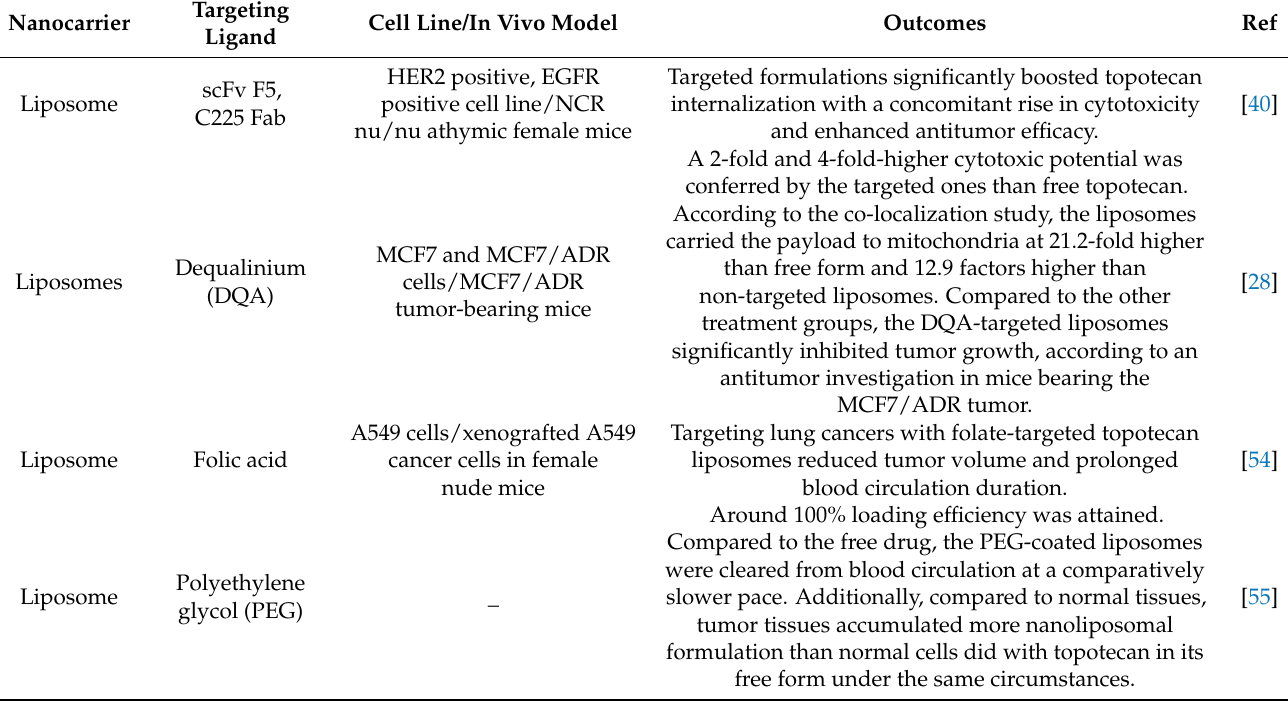
Table 1. List of studies about the targeted delivery of topotecan in the liposomal carrier